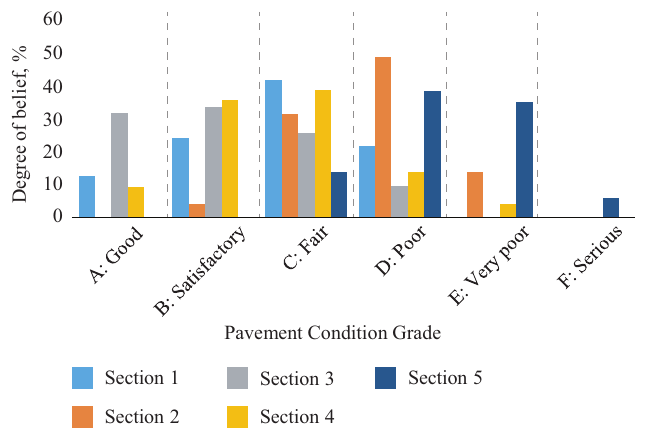
Figure 3. Overall condition assessments of the five pavement